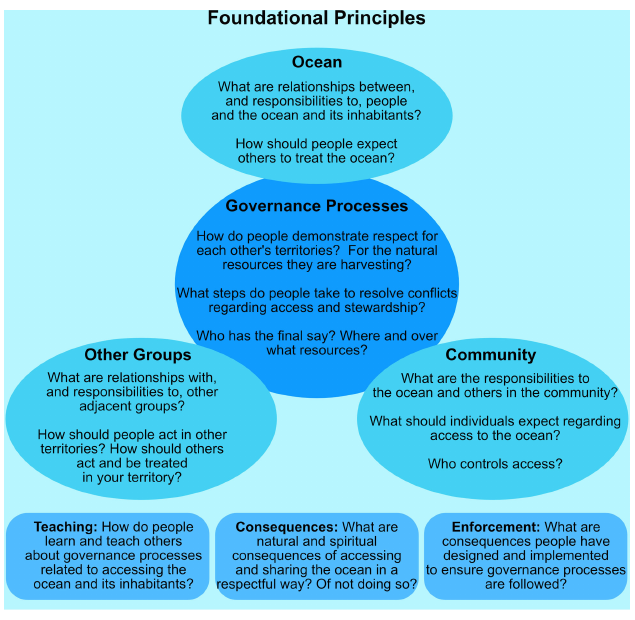
Fig. 2 . The analytical framework used to synthesize Kitasoo/ Xai’xais marine governance principles and protocols. The framework was adapted from the Indigenous Law Research Unit (2010) but was simplified and made specific to the ocean and its inhabitants. The foundational principles underpin all the other components. The ovals depict the guiding questions for components of governance related to people’s relationship to the ocean, to the community, and to other groups, which all link to the governance processes. The boxes provide questions that are important for all the components, regarding